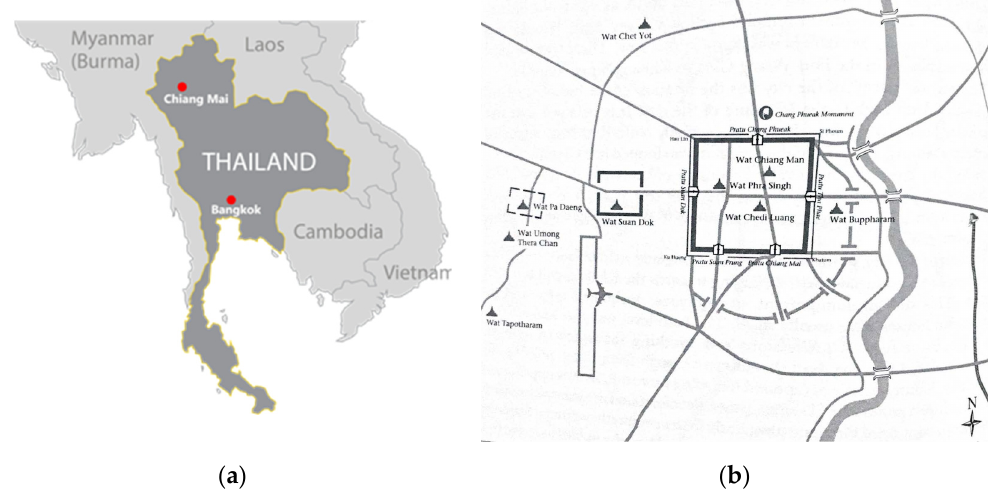
Figure 1. ( a ): The location of Chiang Mai in Thailand (Author). ( b ) The Map of Chiang Mai with the significant places (Ongsakul et al. 2005, p. 68).